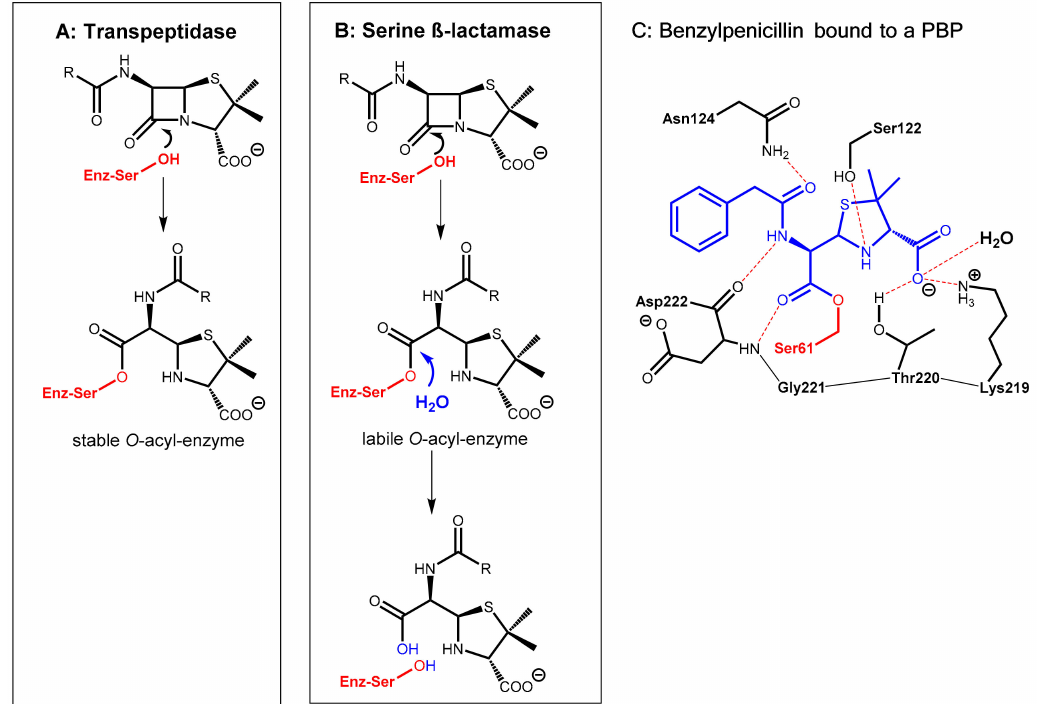
Figure 1. ( A ): Formation of a stable O -acyl-enzyme complex by reaction of the β -lactam antibiotic with the bacterial target enzyme (in red) is the molecular basis of the antibacterial activity. ( B ): Hydrolysis of the β -lactam antibiotic by bacterial β -lactamases leads to a loss of antibiotic activity. ( C ): Active site view from a crystal structure of a penicillin-binding protein (PBP) from Thermosynechococcus elongates acylated by benzylpenicillin (in blue) (PDB ID: 2J8Y).